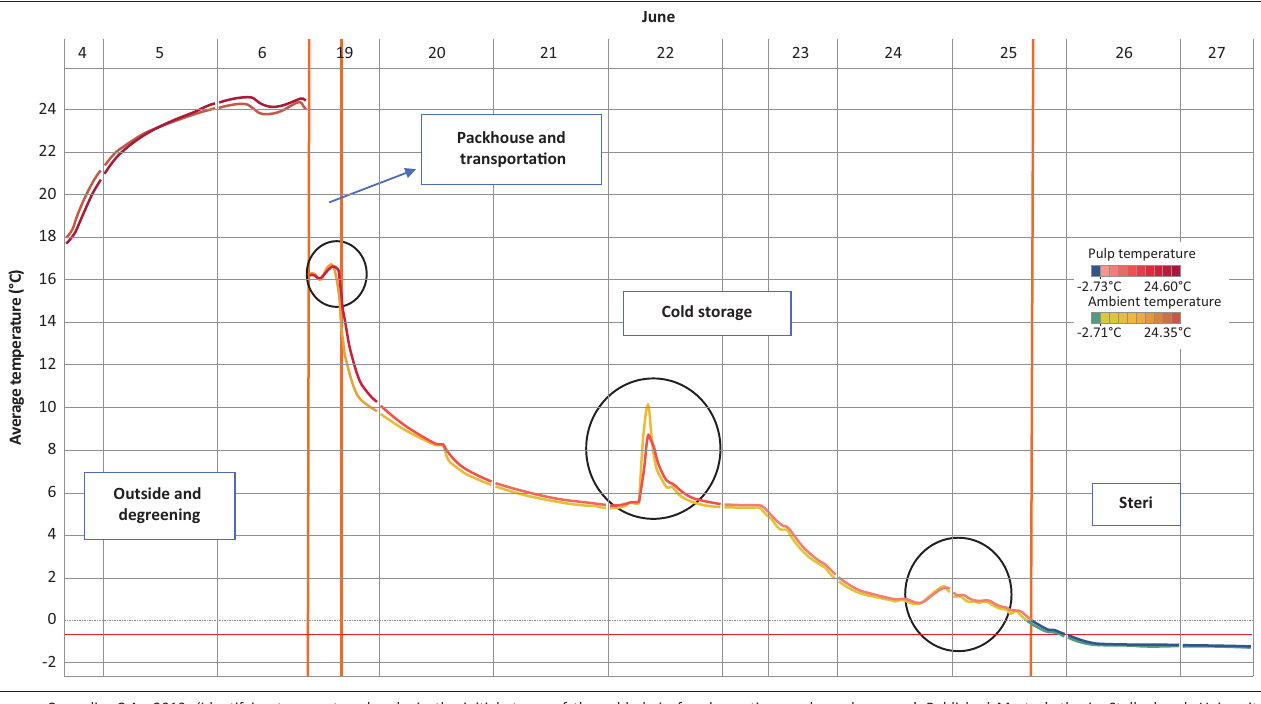
FIGURE 6: Time-series line graph of clementines load two: Pulp and ambient